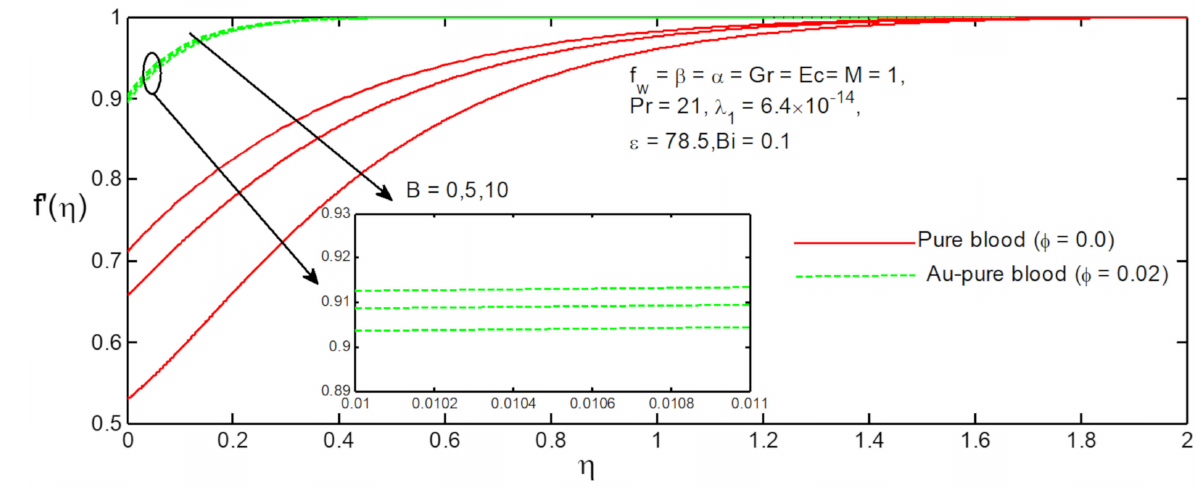
Figure 10. Influence of B on f (cid:48) ( η ) .